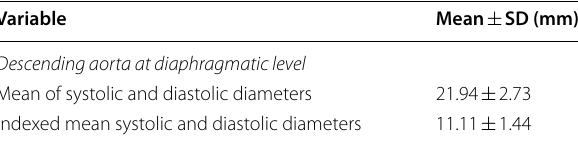
Table 7 Diameters of descending aorta at diaphragmatic level